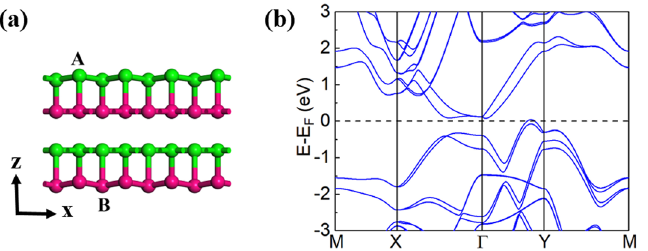
Figure 4. ( a ) The side view of the bilayer BP with a 5.5% compressive strain, where the M z symmetry is broken by shifting the A and B atoms 0.01 and − 0.01 Å along the z axis, respectively. ( b ) Band structure of the bilayer BP shown in ( a